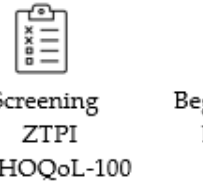
Figure 1. Study diagram.